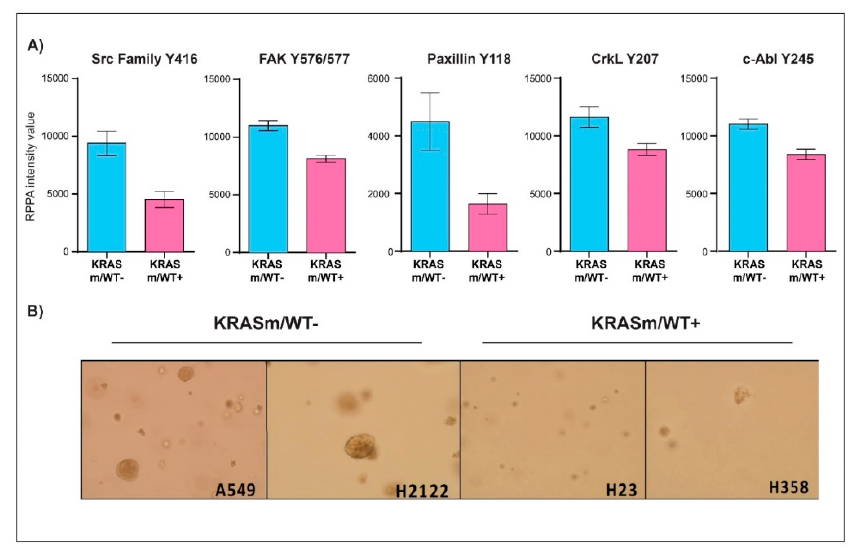
Figure 5. Anchorage-independent growth is enhanced in KRASm/WT − NSCLC cell lines. Bar graphs display mean and standard error of the mean of expression and activation of key signaling molecules involved in anchorage-independent growth in KRASm/WT − (A549, H2122) and KRASm/WT+ (H1734, H23, H358) ( A ). Colony formation assay shows larger and more abundant colonies in the KRASm/WT − cell lines compared to KRASm/WT+ models ( B ), confirming increased anchorage-independent growth in the KRASm/WT lines.